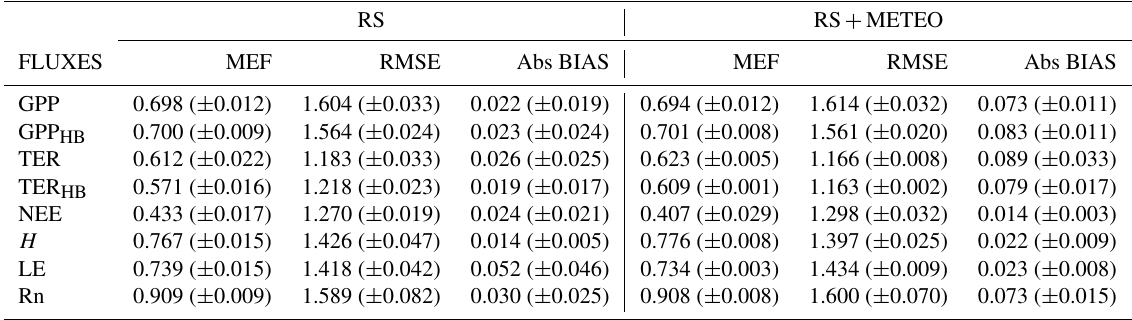
Table A1. Accuracy of CO 2 and energy fluxes predicted by the machine learning method based on the RS and RS + METEO setup. The median value and the standard deviation across methods (in parentheses and estimated as reported in Jung et al., 2009) are shown. Reference units for RMSE and absolute BIAS, were gCm − 2 d − 1 and MJm − 2 d − 1 for CO 2 fluxes (GPP, TER and NEE) and energy fluxes (H, LE and Rn),